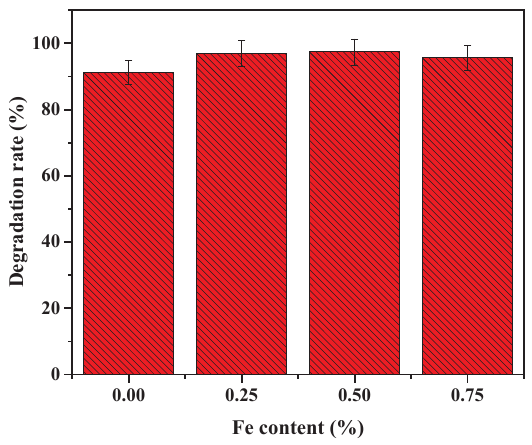
Figure 5: Effect of Fe 3+ ion content on sonocatalytic activity of Fe-doped TiO 2